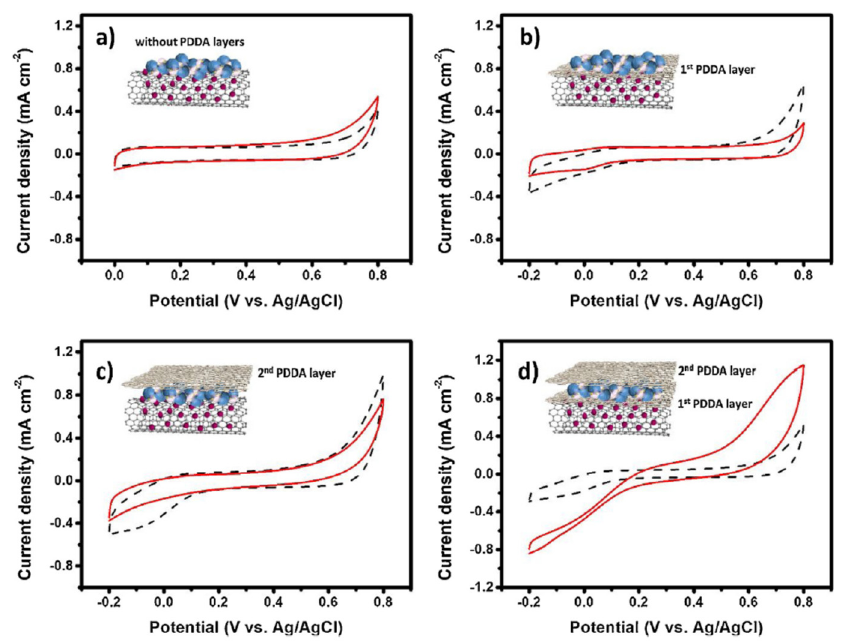
Figure 2. CV curves of catalysts using amine-CNT/hemin, PDDA layers and GOx. ( a ) (Amine- CNT/hemin)/GOx, ( b ) (amine-CNT/hemin)/PDDA/GOx, ( c ) (amine-CNT/hemin)/GOx/PDDA, and ( d ) (amine-CNT/hemin)/PDDA/GOx/PDDA, without the injection of glucose (black dashed line) and with the injection of 30 mM glucose (red solid line). For the tests, 0.01 M PBS (pH 7.4) was used as an electrolyte under air condition [41]. Copyright 2020 Elsevier.